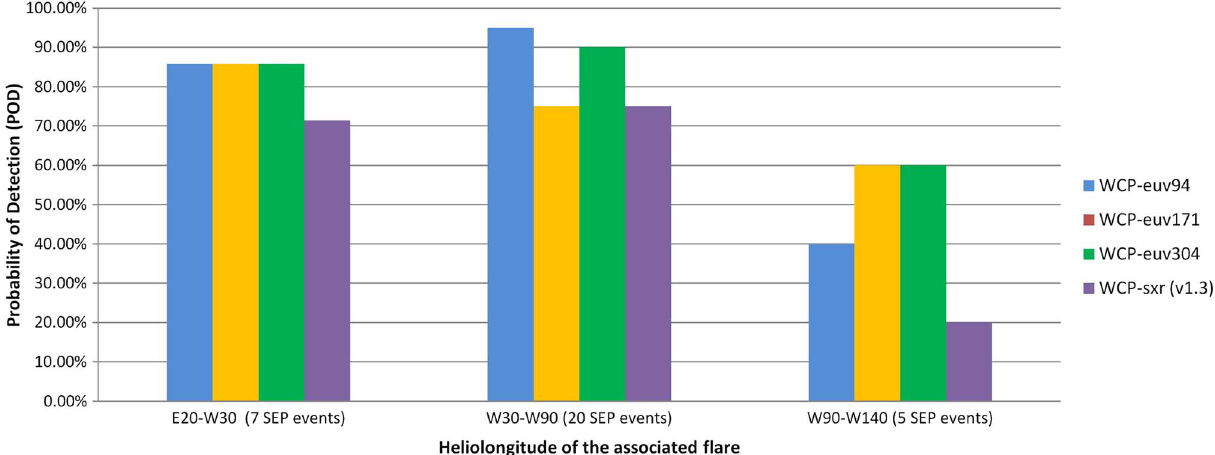
Fig. 4. Distribution of POD of the WCP scheme using AIA EUV and GOES SXR data for the period 2010